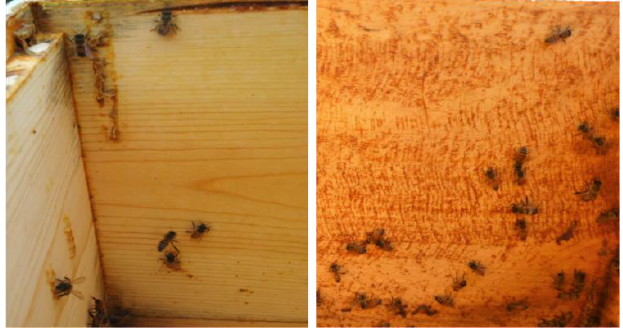
Figure 3. Conventional smooth box with propolis placement in corners and at frame rests (left) vs. the roughened box interior with a more continuous distribution of propolis.